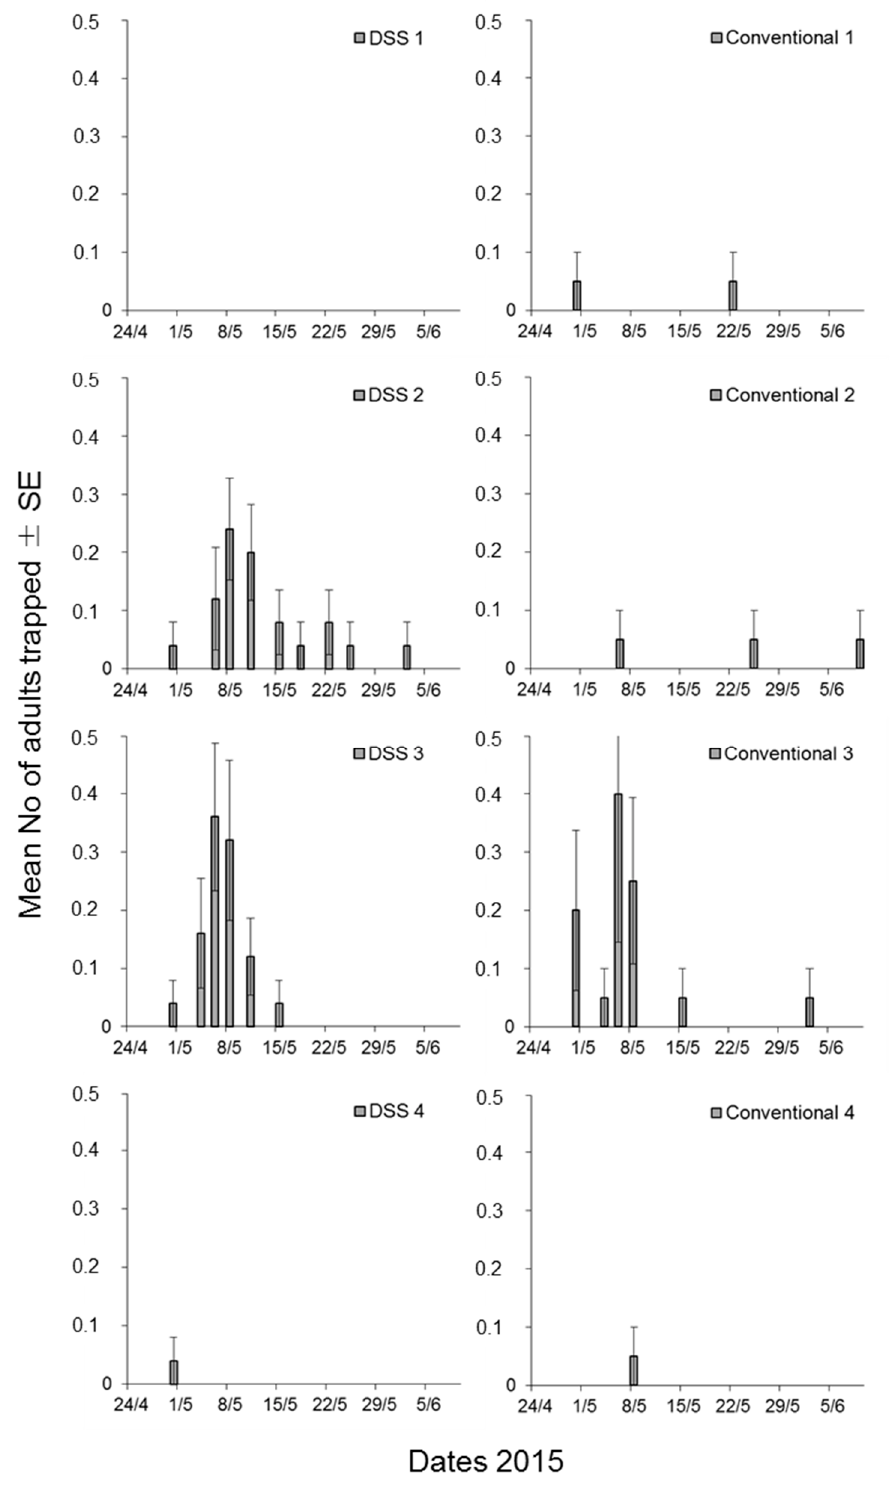
Figure 6. Trapping trends of Rhagoletis cerasi during the cherry maturing period of 2015 in the DSS-supported and Conventional experimental plots.